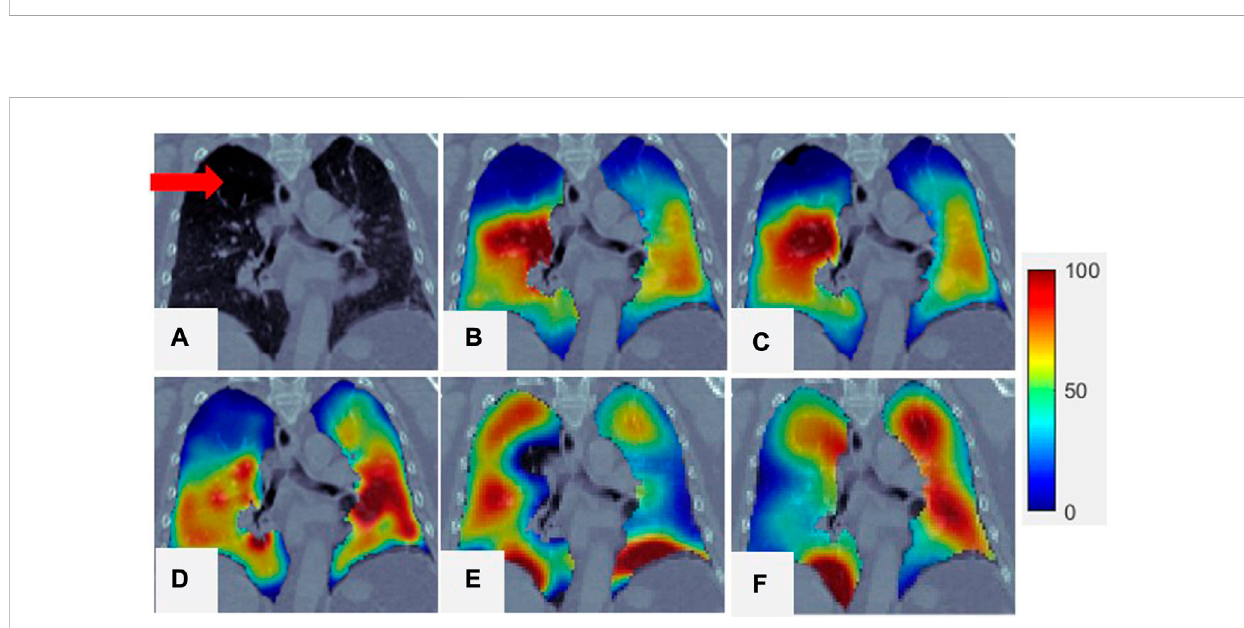
FIGURE 4 Comparison of SPECT image and CTVI SVD images for arepresentative case. (A) Is CT; (B) isthe SPECT of thelung region superimposed ontothe CT; (C) is the VI SV of thelung region superimposed onto theCT; (D) is theCTVI SVD of thelung region superimposed onto theCT; (E) is theCTVI Jac of thelung region superimposed onto the CT; (F) is the CTVI HU of the lung region superimposed onto the CT. For all the fi gures, their 99th percentile and higher values were scaled to 100 (to reduce the artifact effect caused by the tracer deposited at airways in SPECT for visual inspection), and the minimum value was scaled to